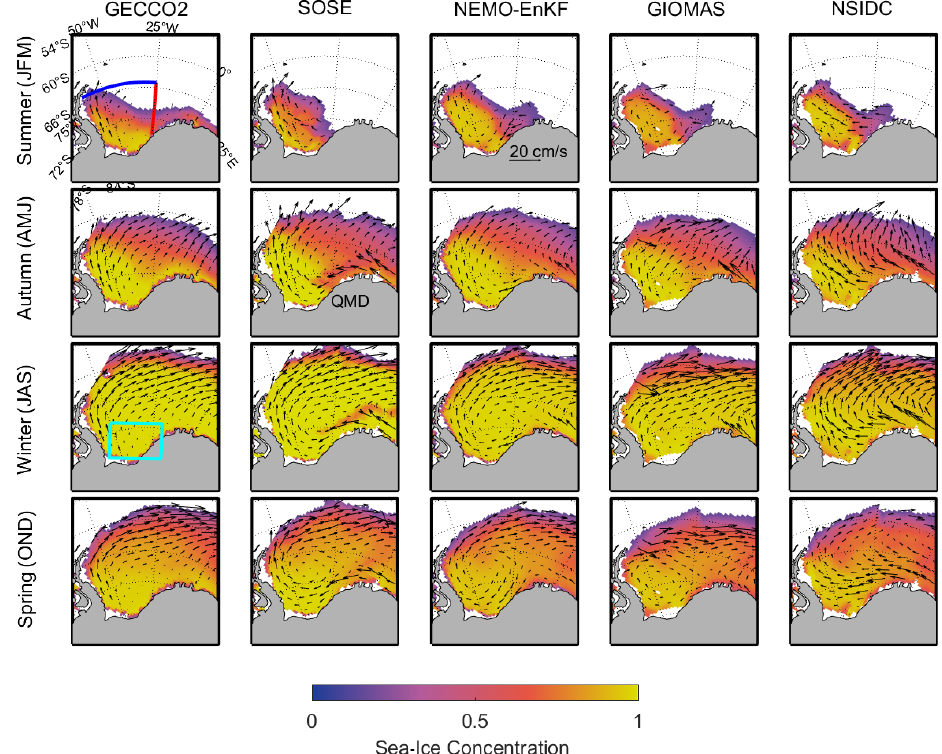
Figure 8. Seasonal mean sea-ice concentration (summer to spring) for the 4 year period 2005–2008. The overlapped vectors represent sea-ice velocity from respective data